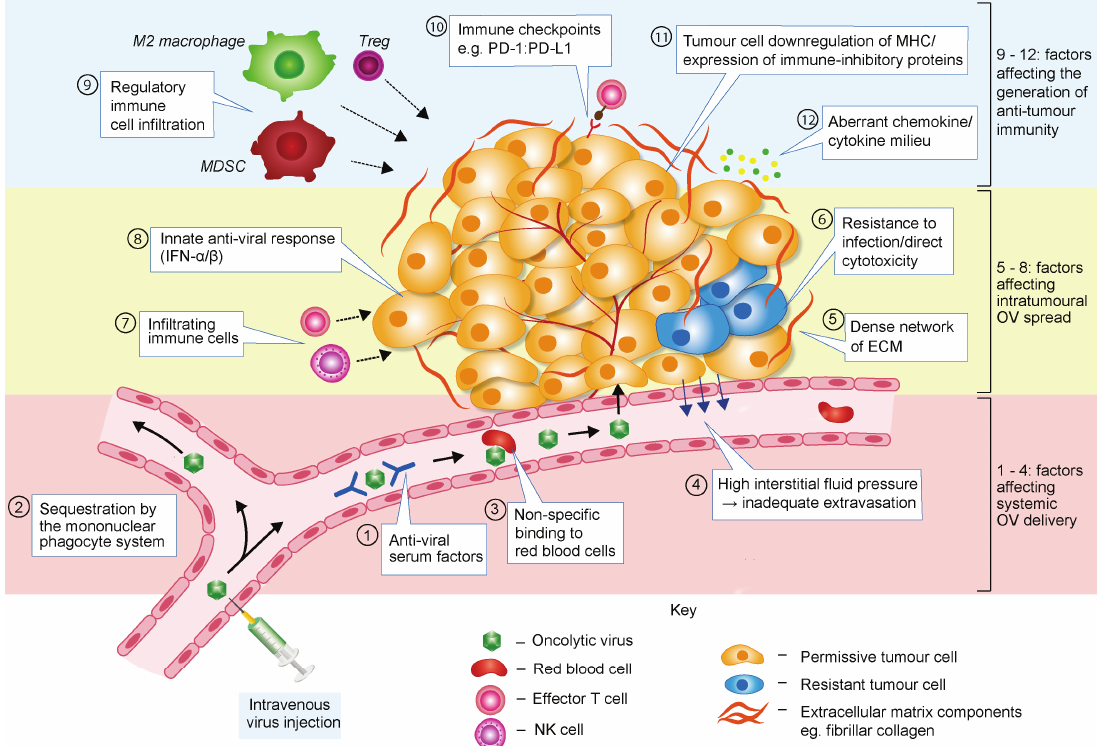
Figure 2. Barriers to effective OV therapy. When delivered to tumours via the bloodstream, oncolytic viruses (OVs) are vulnerable to anti ‐ viral serum factors such as complement proteins and neutralising antibodies (box 1). Binding of these factors accelerates OV clearance from the circulation by macrophages in the liver, lungs and spleen (the mononuclear phagocyte system) (box 2). Systemic delivery of OVs may be further compromised by their non ‐ specific binding to red blood cells (box 3). Once the target site is reached, an additional hurdle is posed by high interstitial fluid pressure within the tumour, which disfavours OV extravasation from the vasculature (box 4). Following extravasation, or after intratumoural OV injection, several factors may limit intratumoural viral spread and therapeutic effectiveness. Abundant extracellular matrix (ECM) and high interstitial fluid pressure represent physical barriers to OV spread by impeding virus diffusion between cells (box 5). Cancer cells within a tumour are likely to be heterogeneous in their susceptibility to virus infection and capacity to support the OV life cycle, with some cells displaying residual intracellular anti ‐ viral activity and/or resistance to OV ‐ mediated cell killing (box 6). Some viruses may also bind normal interstitial cells with a similar affinity as tumour cells, resulting in OV sequestration away from the target cancer cell (not illustrated in the figure). Infiltrating and resident innate immune cells (such as NK cells or macrophages) and anti ‐ viral T cells will also contribute to limit the magnitude of viral production and spread (box 7). In some tumour cells (or normal stromal cells), virus infection may multiplication (box 8). The immune ‐ tolerant tumour microenvironment may hamper OV ‐ induced